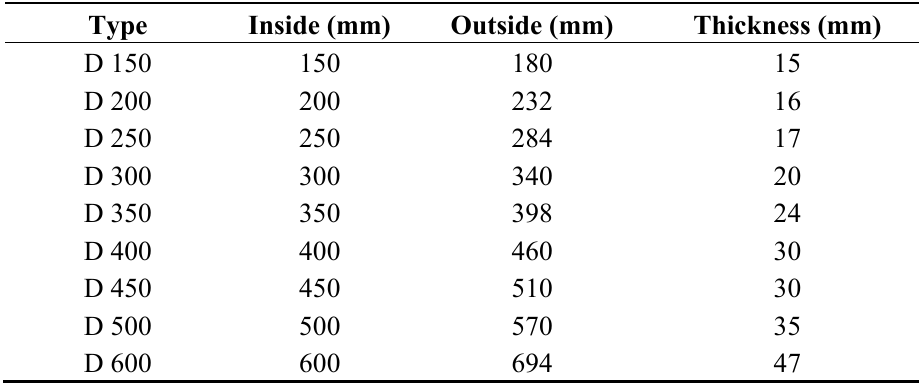
Table 1. Dimensions of polyethylene (PE) pipe in